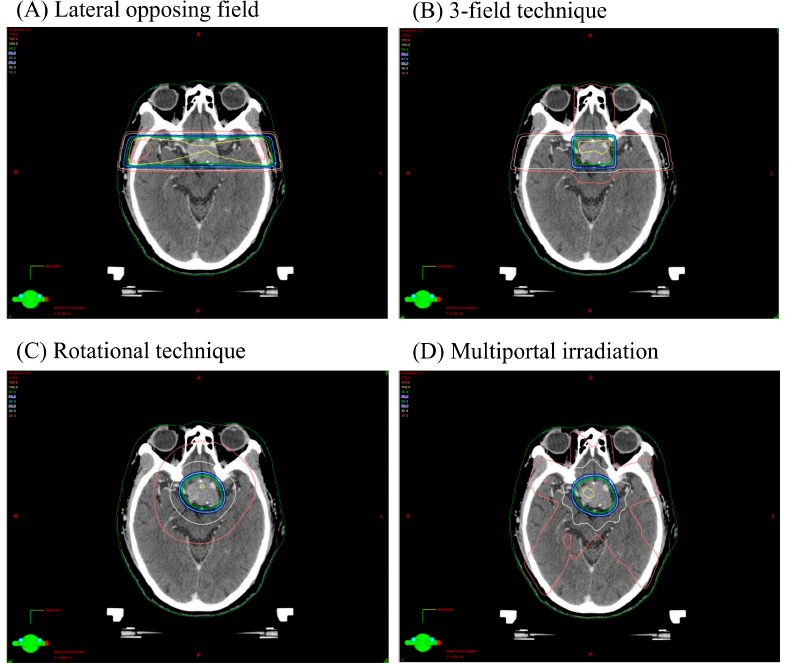
Figure 4. Typical isodose plan of lateral opposing field ( A ), 3-field technique ( B ), rotational technique ( C ), multiportal irradiation ( D ) for a case of non-functioning pituitary adenoma. The lesion dose is 4500 cGy/25 fractions and isodose lines corresponding to 30%, 50%, 80%, 85%, 90%, 95%, 100% of the target dose are shown.